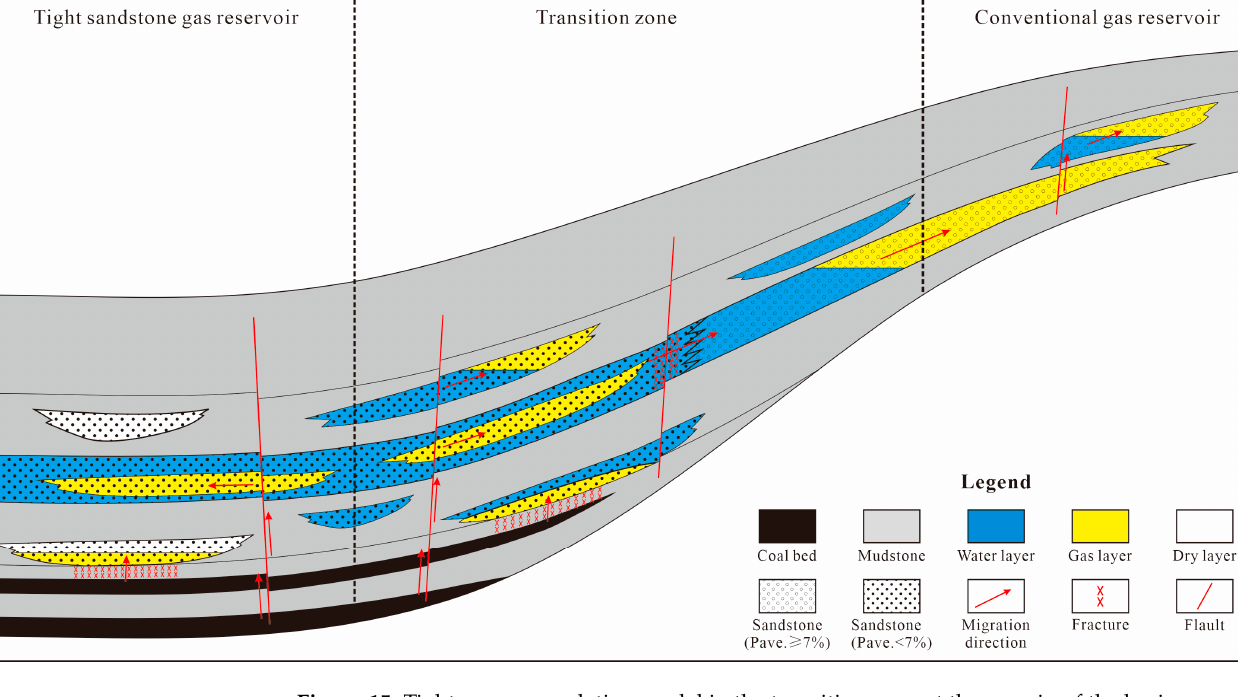
Figure 15. Tight gas accumulation model in the transition zone at the margin of the basin.